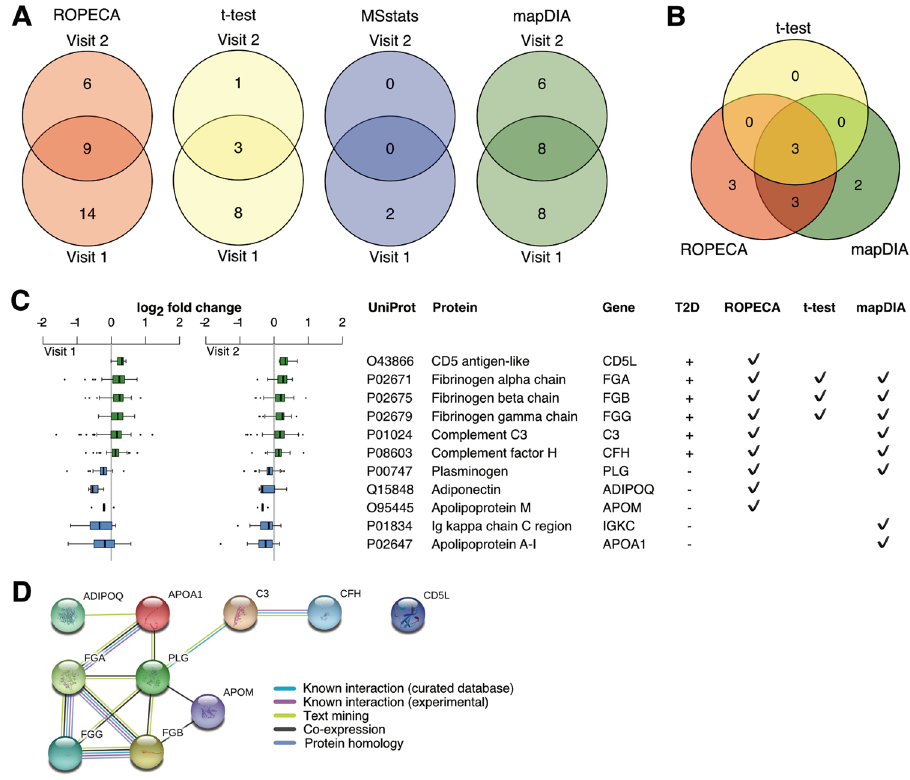
Figure 4. Differentially expressed proteins in type 2 diabetes (T2D). ( A ) Overlaps of differentially expressed proteins (FDR < 0.05) in the two follow-up visits using ROPECA, t -test, MSstats, and mapDIA. ( B ) Overlaps of the differentially expressed proteins between the different methods. MSstats was omitted as it did not report any proteins on both visits. ( C ) Fold changes of the differentially expressed proteins on both visits. Only proteins with fold change to the same direction on both visits and identified using more than a single peptide were included. ( D ) Known protein-protein interactions between the differentially expressed proteins shown in panel C reported in the STRING